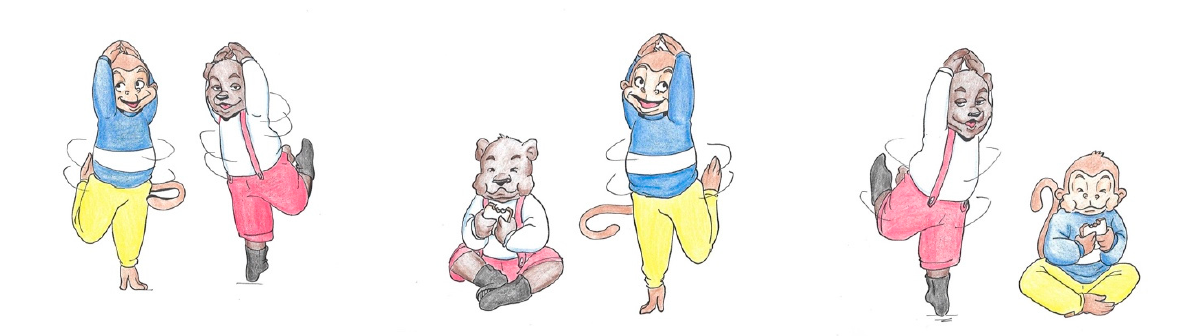
Figure A29. Filler stimulus 4.